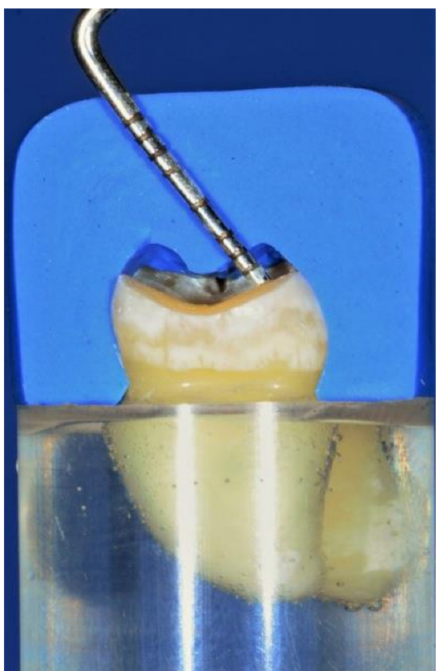
Figure 1. The pre-preparation silicon index was used to check the amount of tooth reduction (1 mm to simulate the wear and 1 mm to create a space for a 1 mm thickness